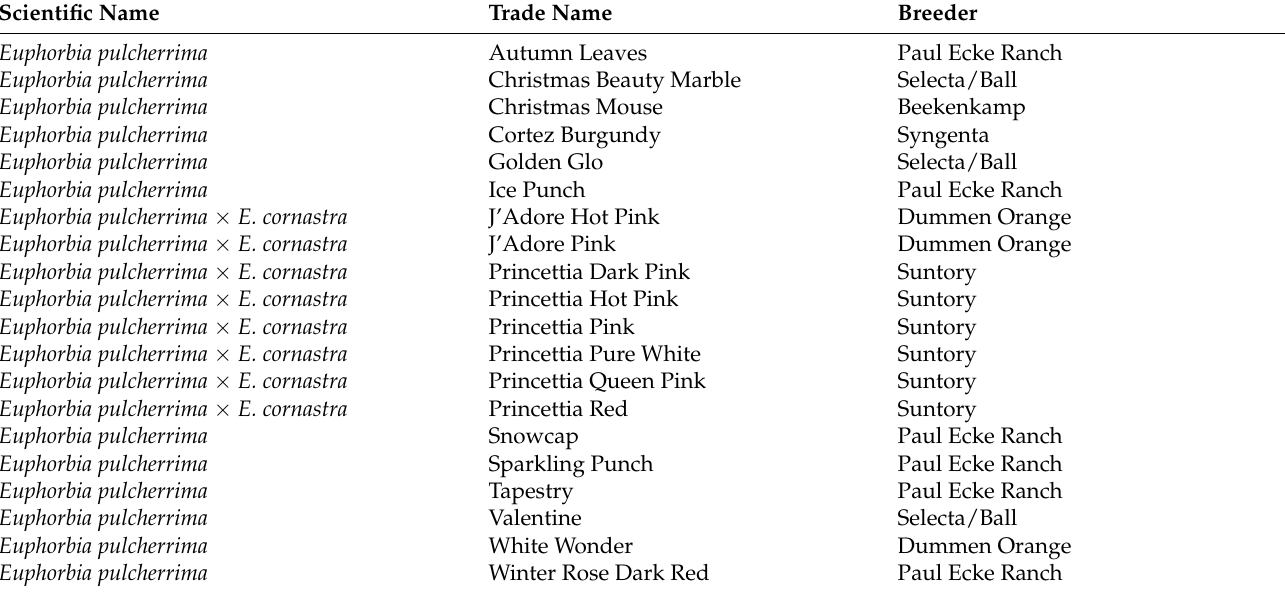
Table A1. Scientific and English names and breeders of 20 poinsettia cultivars used in the level of liking online